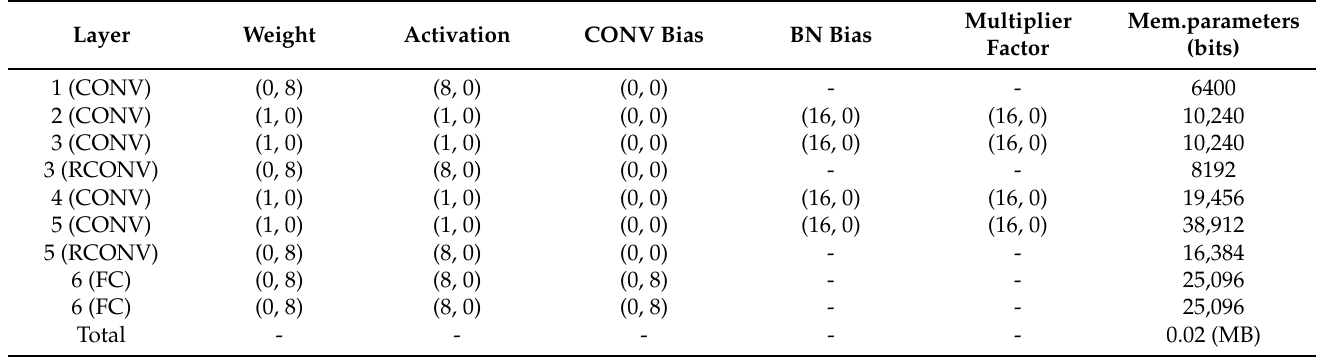
Table 1. Quantization strategy for all parameters of each layer on EBDN